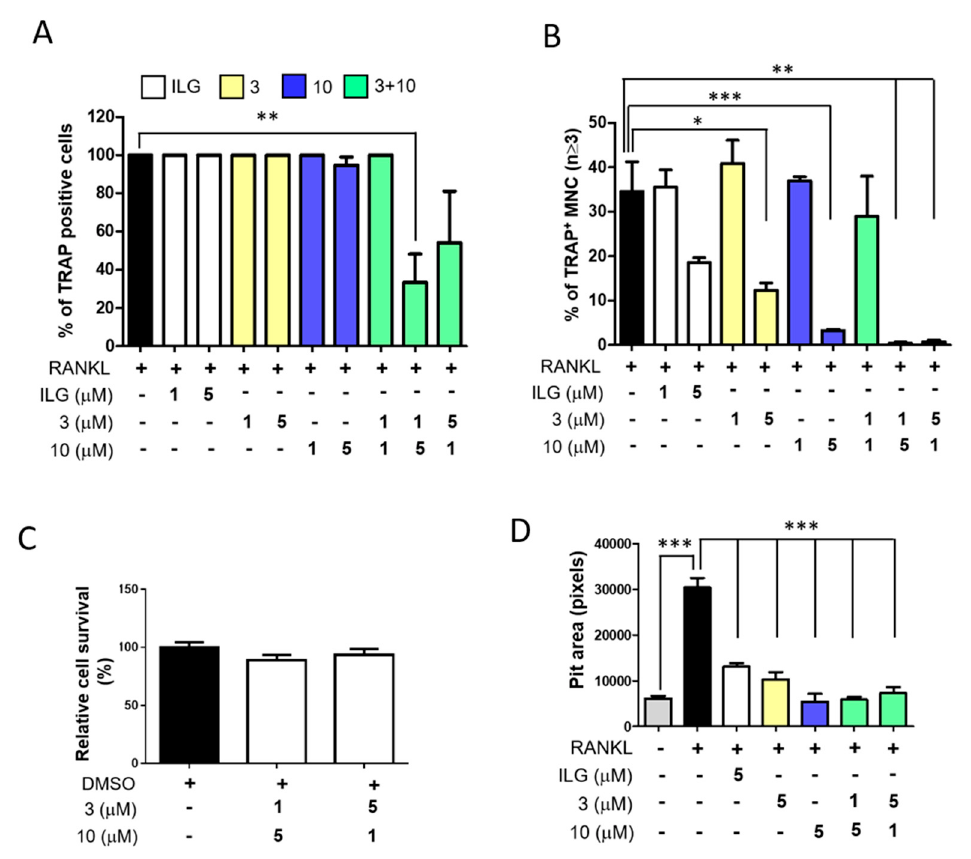
Figure 6. The combination effect of ILG derivative 3 and 10 as osteoclast differentiation inhibitor. RAW264.7 cells were treated with ILG, ILG, derivatives or combination of ILG derivative 3 and 10. ( A , B ) RAW264.7 cells were stimulated with RANKL (40 ng/mL) and stained for TRAP. ( A ) Number of TRAP positive cells that stained for TRAP were counted and ( B ) TRAP-positive cells (having more than three nuclei) were counted as osteoclast. ( C ) The cytotoxicity of ILG derivative 3 and 10 combination for RAW264.7. ( D ) Resorption pit areas by ILG combination compounds were measured. * p < 0.05, ** p < 0.01, *** p < 0.001. ( n ≥ 3).